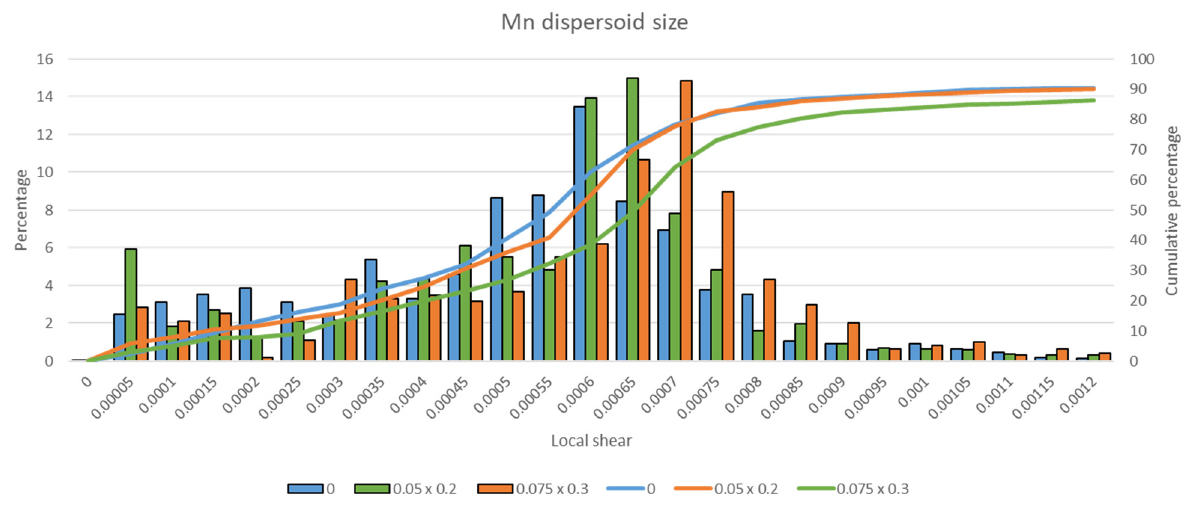
Figure 9. DDD simulation results from Mn dispersoid size on the local for fv = 0.0045%. Sizes are in µ m. Label 0 refers to a